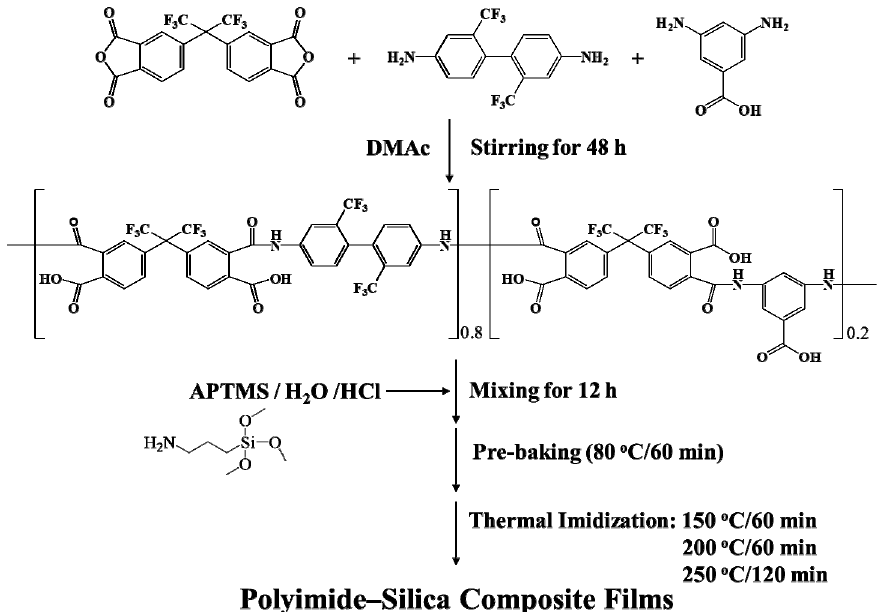
Figure 1. Chemical structure of poly(amic acid) (PAA) and the preparation procedure for the PI–silica composite